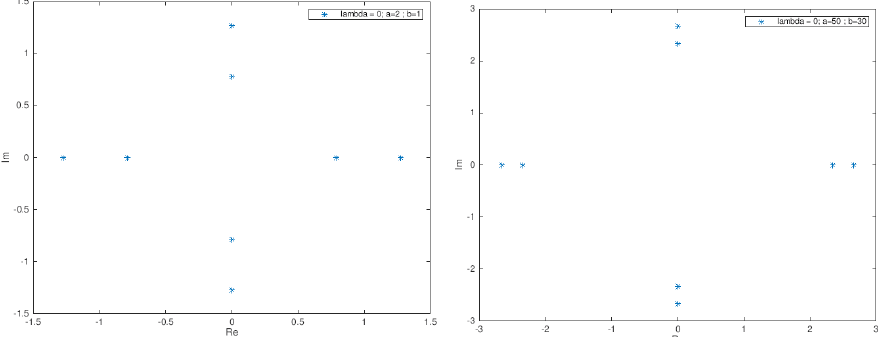
Figure 12. Homotopy graph for λ = 0 and different values for a , b . Note that the complex conjugate eigenvalues converge to the imaginary axis.